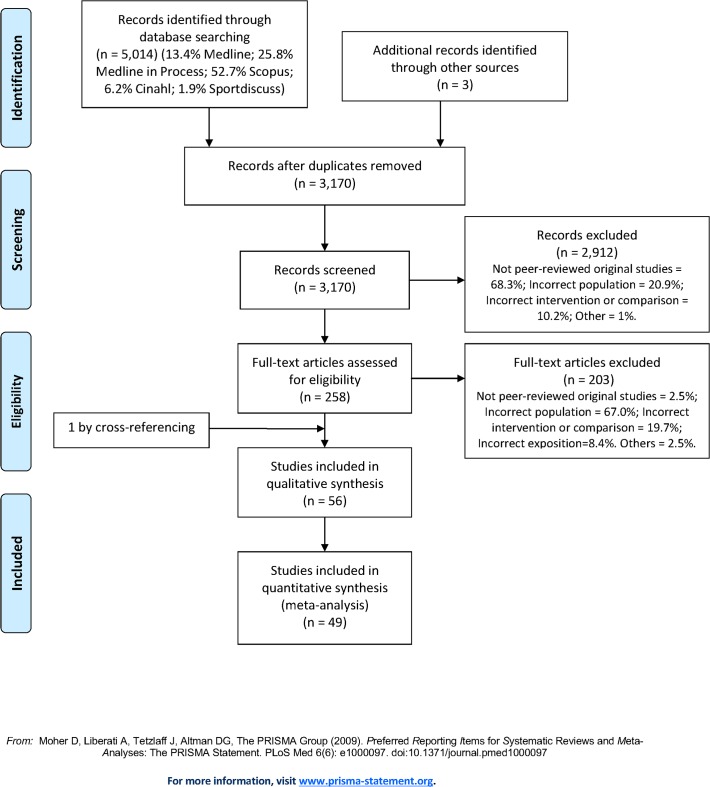
PRISMA 2009 Flow Diagram.